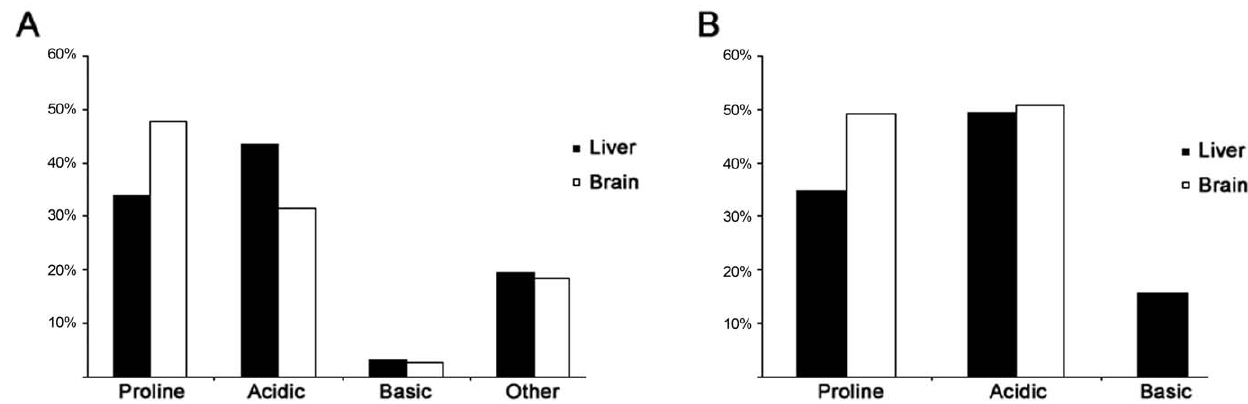
Figure 2. Tissue specific kinase motifs. A , The amino acid following the phosphorylated amino acid was categorized as proline, acidic, basic, or other. The majority of these amino acids were either proline or acidic. The y-axis represents the percentage of phosphopeptides, where the phosphorylation site could be confidently localized. B , The Motif-X algorithm was employed to determine if any kinase motifs existed in the data. The percentage of peptides that contained a proline, acidic, or basic residue in their motif was plotted. For peptides which contained two of these residues, they were counted in both categories. The majority of motifs contained either a proline or acidic residue.